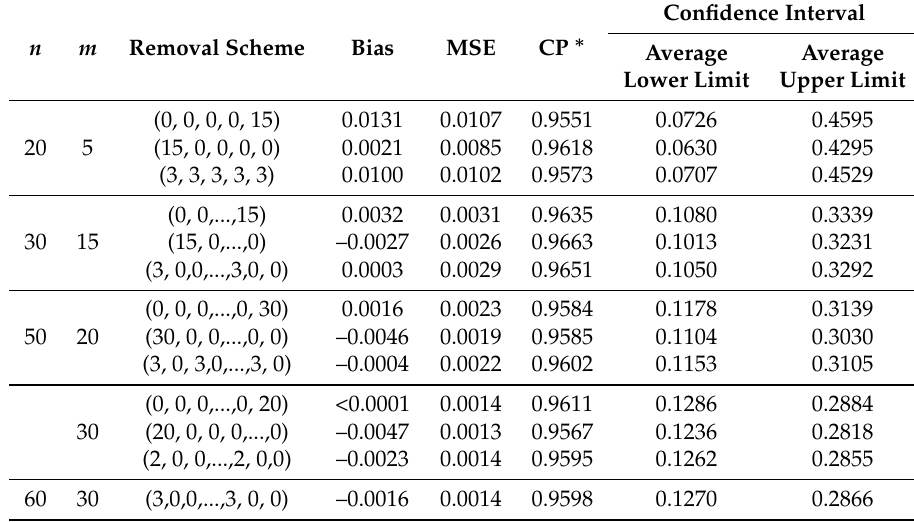
Estimation results of δ s , k using the parametric percentile bootstrap method for